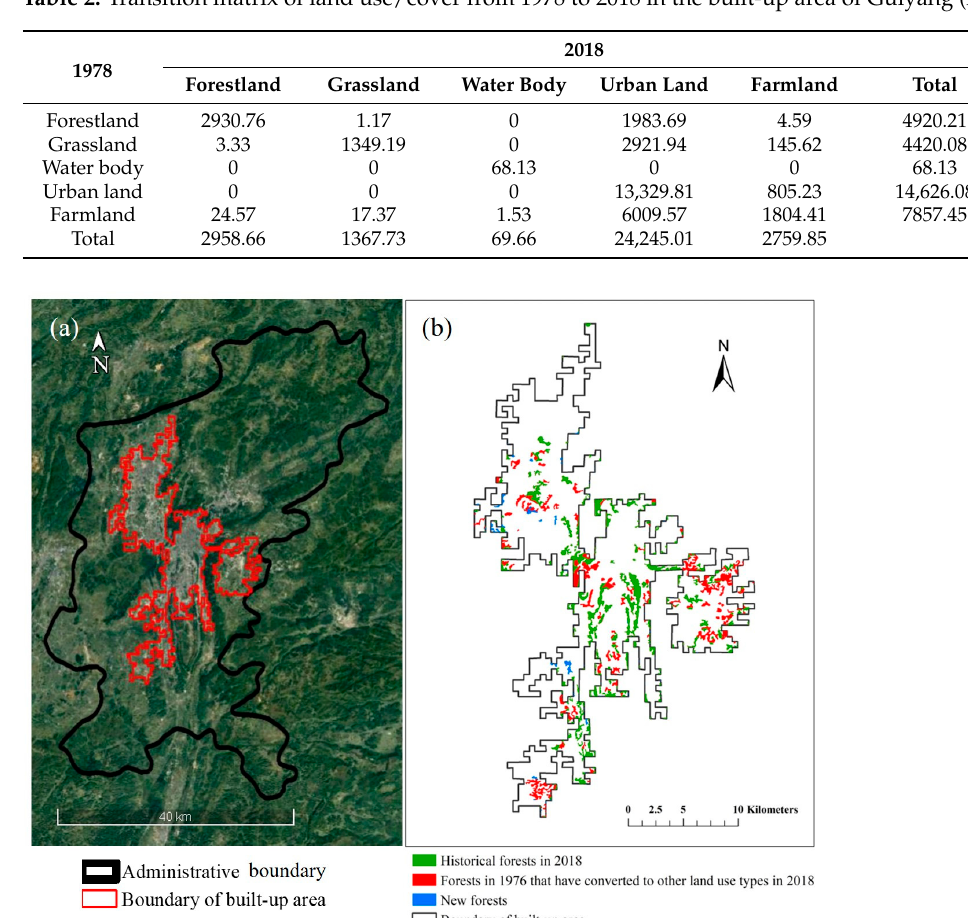
Figure 5. The locations of historical forests. ( a ) The administrative boundary (black line) and boundary of the built-up area (red line); ( b ) locations of historical forests that were retained, those that were transformed, and new forests.